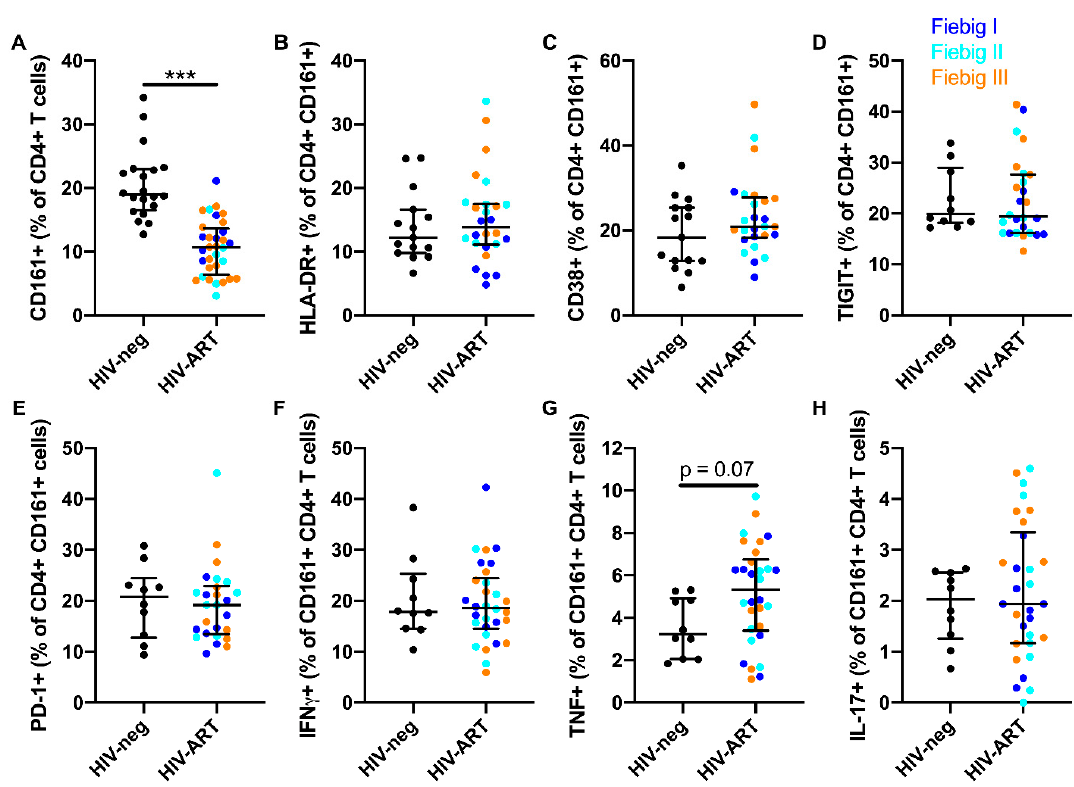
Figure 5. ART initiation during AHI restores normal phenotype and functions, but not the frequency of peripheral CD161 + CD4 + T cells. Frequency of peripheral CD161 + CD4 + T cells in HIV-uninfected ( n = 20) and HIV-infected individuals that initiated ART during Fiebig stage I ( n = 8), Fiebig stage II ( n = 7), and Fiebig stage III ( n = 17) ( A ). Levels of HLA-DR ( B ), CD38 ( C ), TIGIT ( D ), and PD-1 ( E ) expression by CD161 + CD4 + T cells in HIV-uninfected ( n = 15 for B and C and n = 10 for D and E ) and HIV-infected individuals that initiated ART during Fiebig stage I ( n = 9), Fiebig stage II ( n = 8), and Fiebig stage III ( n = 17). Production of IFN γ ( F ), TNF ( G ), and IL-17 ( H ) by CD161 + CD4 + T cells following IL-12 and IL-18 stimulation in HIV-uninfected ( n = 10) and HIV-infected individuals that initiated ART during Fiebig stage I ( n = 9), Fiebig stage II ( n = 8), and Fiebig stage III ( n = 17). The lines and whiskers represent the median and interquartile range, respectively. *** p < 0.001.